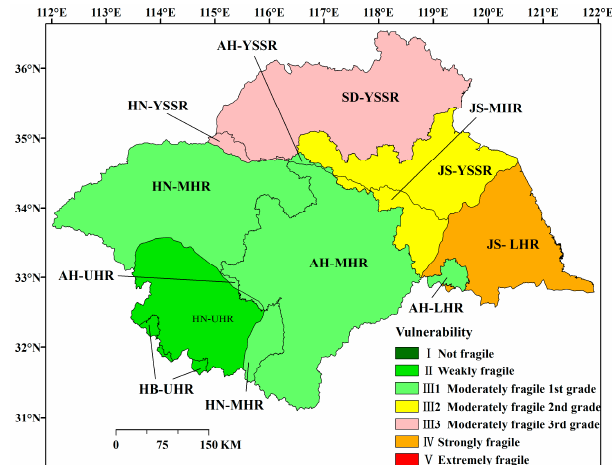
Figure 6. Water resource vulnerabilities in the Huai River Basin at the Province ‐ Class II WRR scale. AH ‐ LHR, Lower reaches of the Huai River in Anhui; JS ‐ LHR, Lower reaches of the Huai River in Jiangsu; HN ‐ MHR, Middle reaches of the Huai River in Henan; AH ‐ MHR, Middle reaches of the Huai River in Anhui; JS ‐ MHR, Middle reaches of the Huai River in Jiangsu; HB ‐ UHR, Upper Huai River in Hubei; HN ‐ UHR, Upper Huai River in Henan; AH ‐ UHR, Upper Huai River in Anhui; SD ‐ YSSR, Yi ‐ Shu ‐ Si River in Shandong; AH ‐ YSSR, Yi ‐ Shu ‐ Si River in Anhui; HN ‐ YSSR, Yi ‐ Shu ‐ Si River in Henan; JS ‐ YSSR, Yi ‐ Shu ‐ Si River in